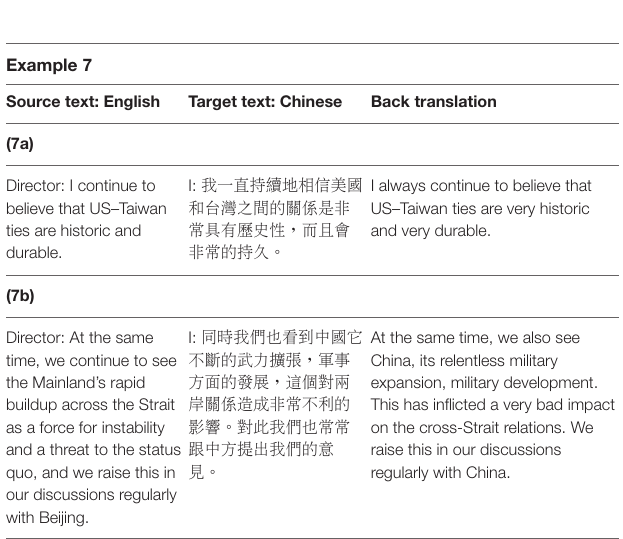
believe ” contributes to the same emphatic effect with respect to Taiwan